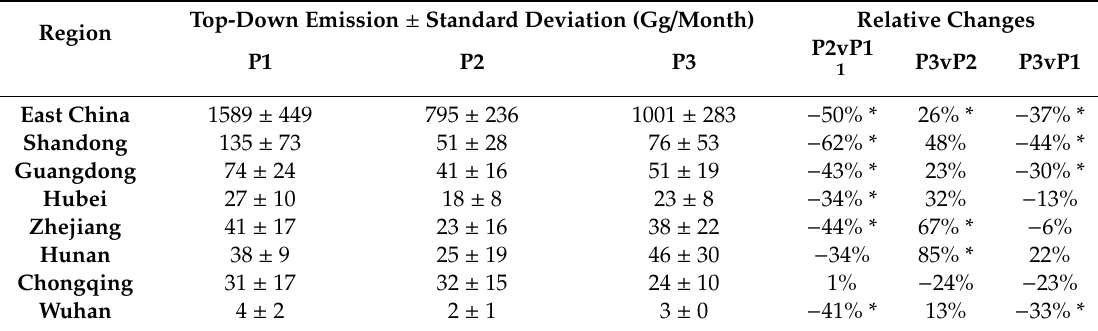
Table 2. Averages and standard deviations (temporal variability) of top-down NOx emissions during the three periods and the relative changes between the three periods. Top-Down Emission ± Standard Deviation (Gg / Region